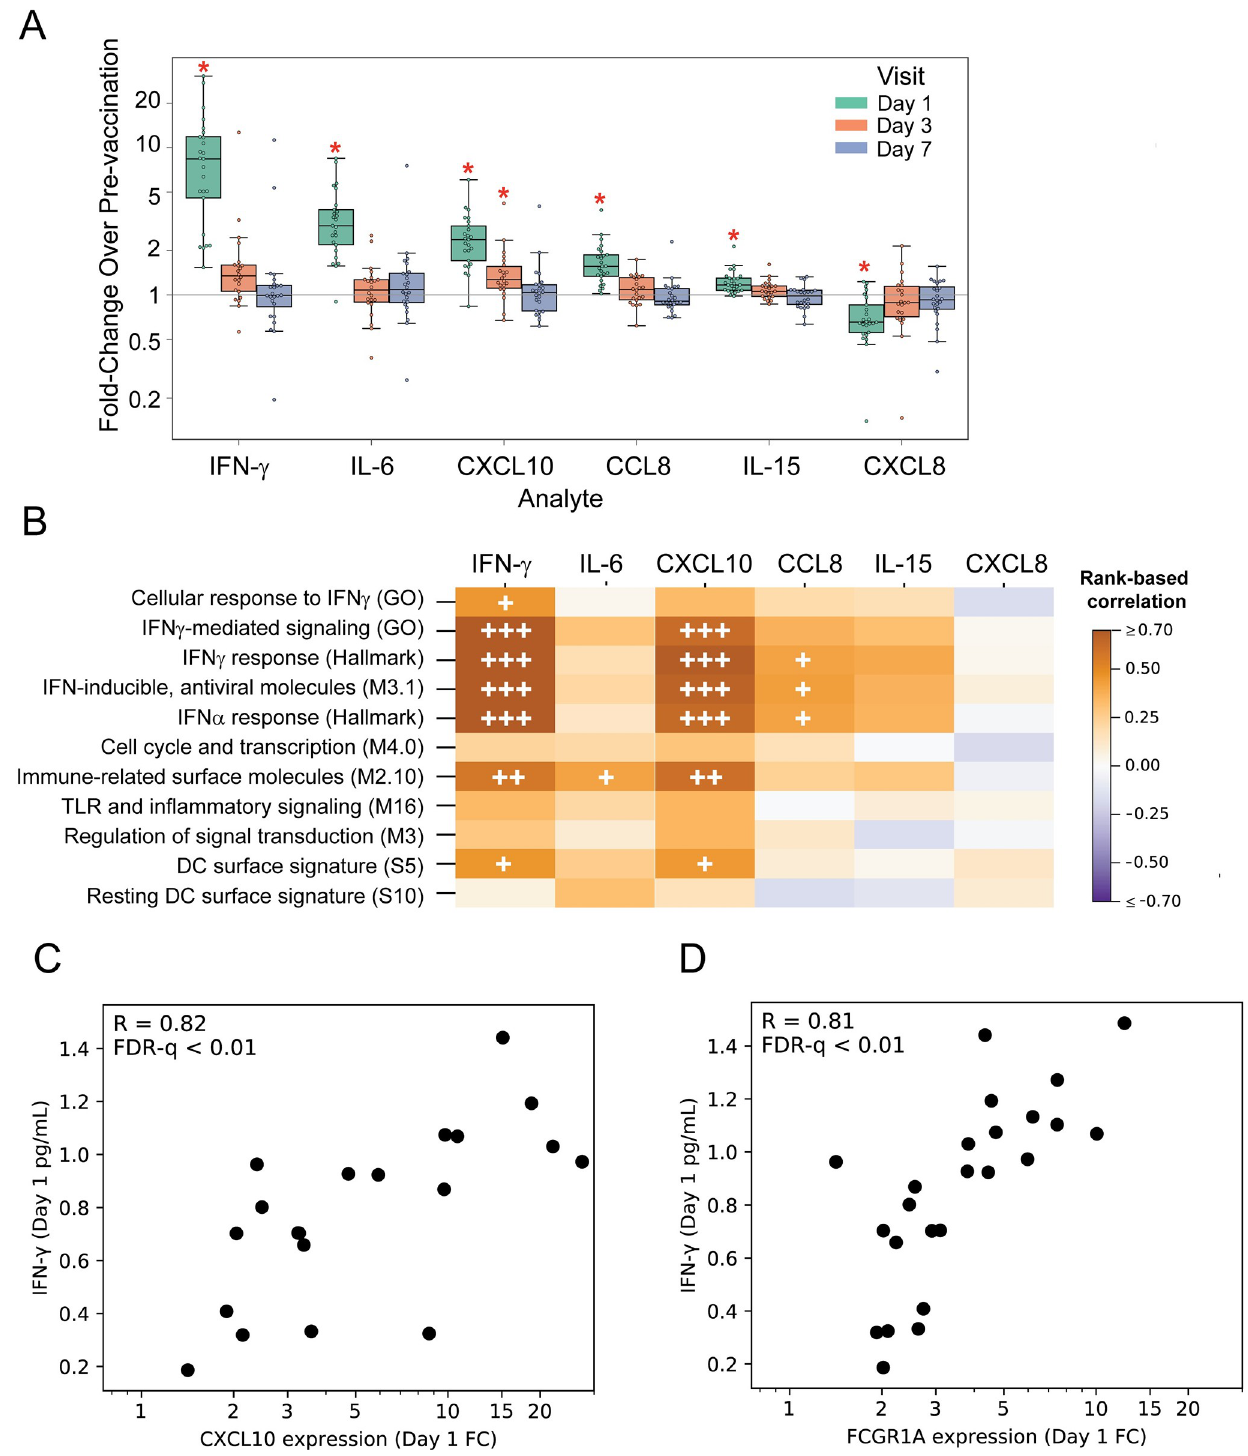
Fig 3. ALVAC-HIV vaccination rapidly induces alterations in serum cytokines and chemokines that are temporally associated with several PBMC gene expression modules (n = 24). A ) Fold-change serum soluble factors after vaccination. Boxes extend through the interquartile range (IQR), with whiskers extending to the lowest and highest points within 1.5 times the IQR. Asterisks denote significant fold-changes in concentration relative to baseline (FWER-p < 0.05, Wilcoxon signed-rank test). B ) Correlations between fold-change in gene expression at Day 1 for each GSEA gene module with significant Day 1 fold-change in serum factor concentration. FDR-q: < 0.2 (+), < 0.1 (++), or < 0.01 (+++). C, D ) Scatterplots of Day 1 fold-change in expression of 2 example genes vs. serum IFN- γ concentrations. Each dot represents a single participant; R values represent the strength of the rank-based correlations.